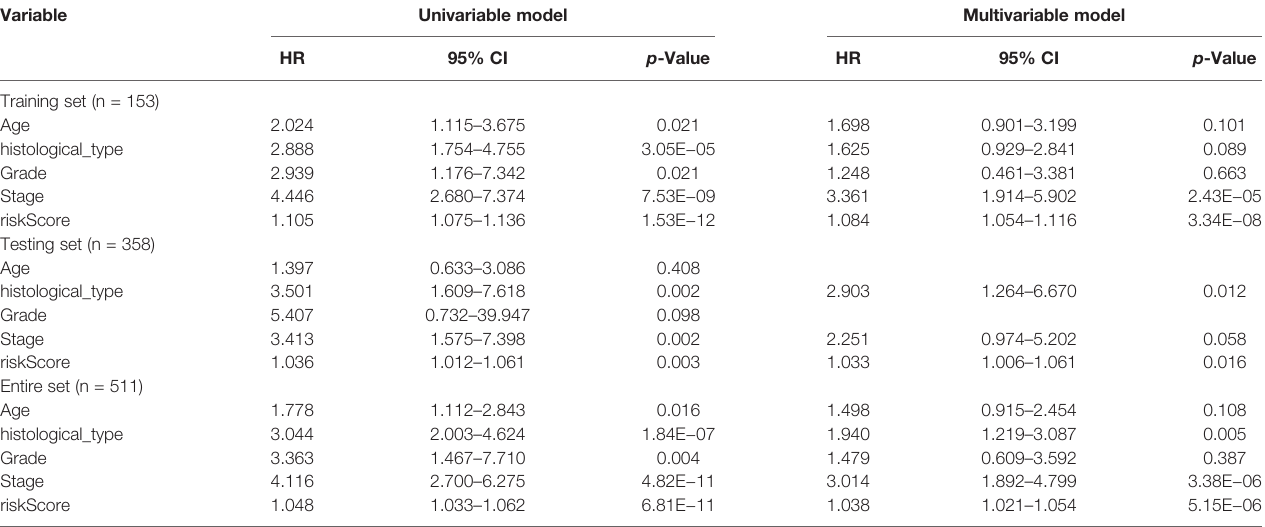
TABLE 2 | Univariate and multivariable Cox regression analysis of the EMT-related genes and overall survival in different patient sets.